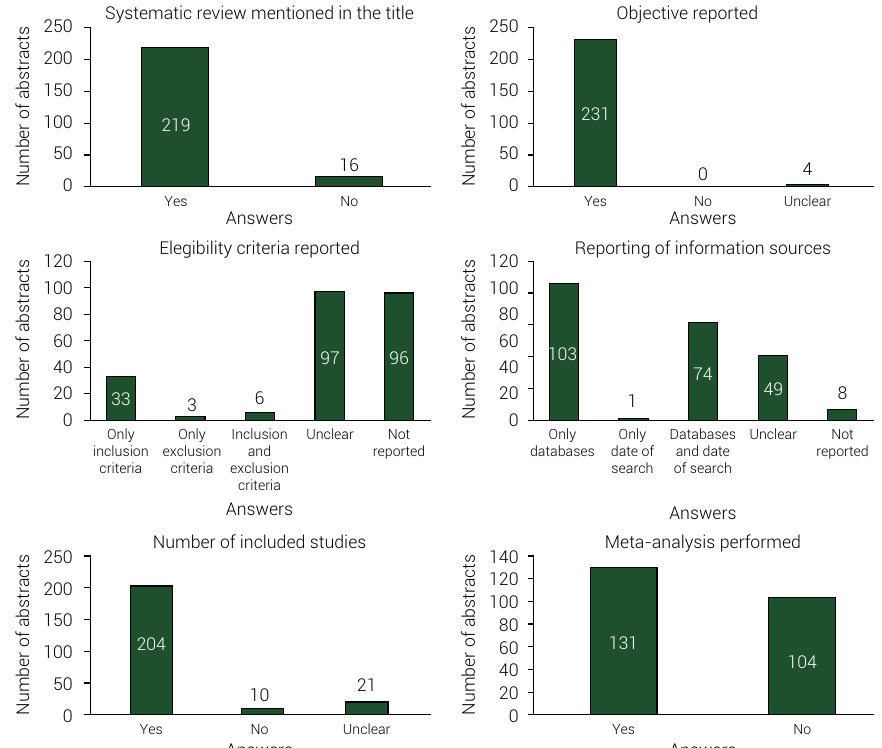
Figure 1. Reporting characteristics of included